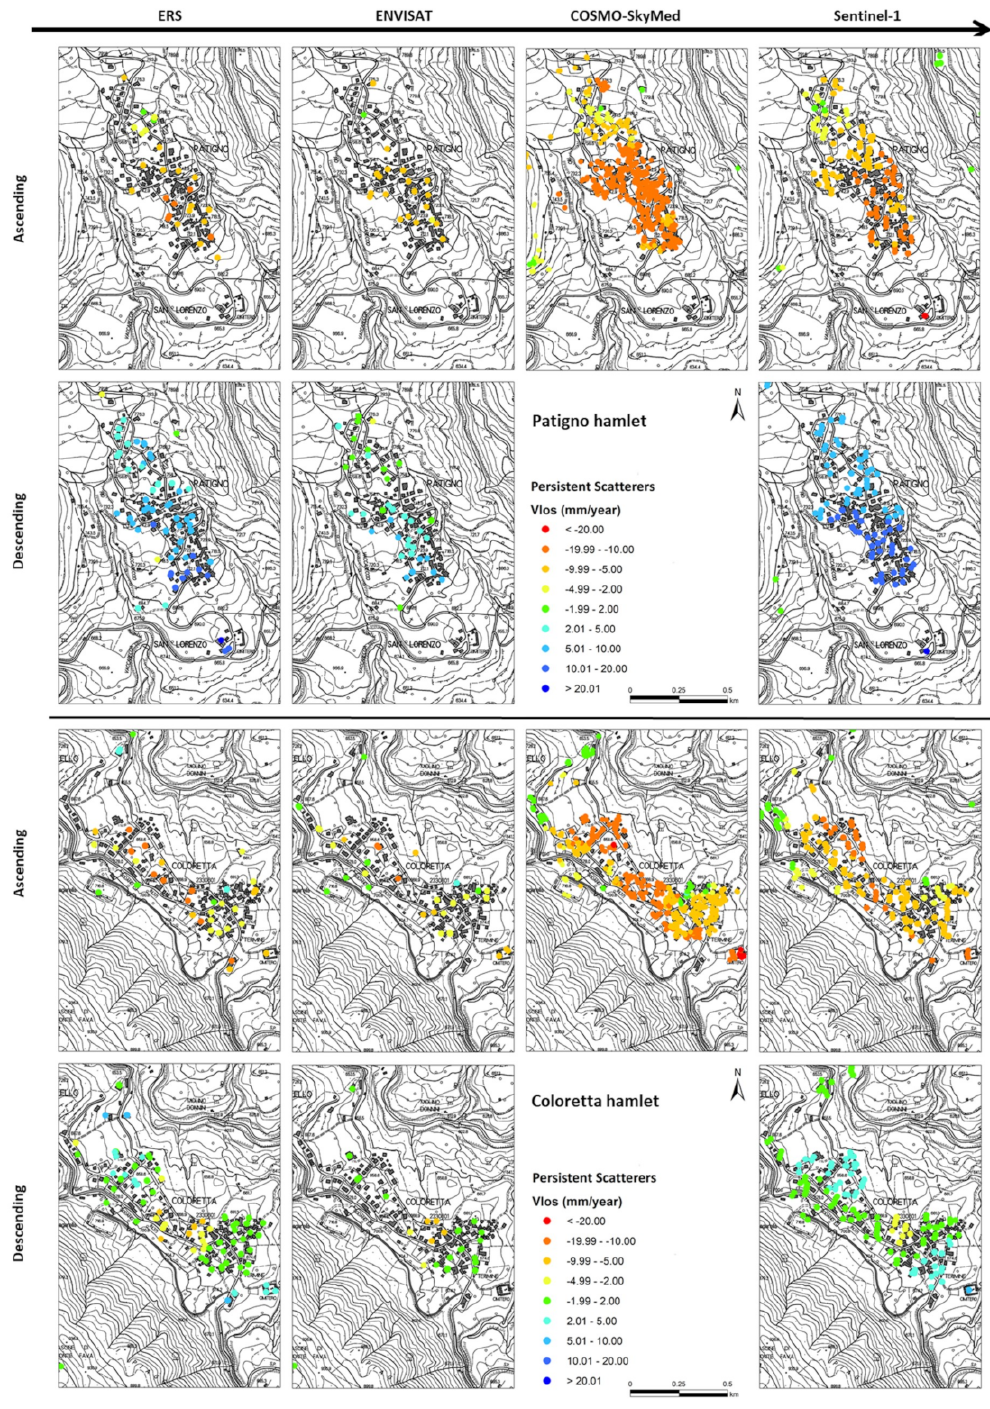
Figure 3. ERS1 / 2, ENVISAT, COSMO-SkyMed and Sentinel-1 PS data for the Patigno and Coloretta hamlets. Vlos is the velocity measured along the satellite Line of